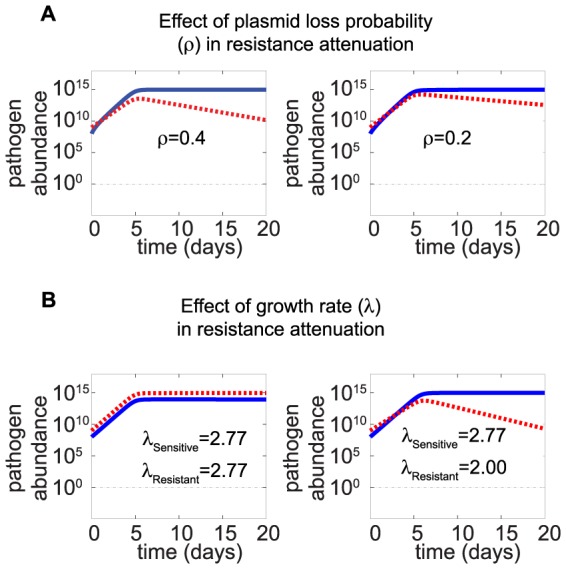
Resistance attenuation occurs in the in the absence of antibiotic treatment when the abundance of sensitive pathogen is saturated.The resistant and sensitive strains have to compete for resources when the bacterial population approaches carrying capacity. This competition reduces the abundance of resistant strains due to the cost of resistance. Under this saturated conditions, both the probability of plasmid loss (A) and the growth rate (B) affect resistance attenuation. (A) The intensity of resistance attenuation increases with the probability of plasmid loss (ρ). (B) The intensity of resistance attenuation increases with the difference in growth rate between both strains. In this analysis, we set up the probability of resistance loss to be equal to zero to highlight only the effects of growth rate. The left panel shows a case in which both sensitive and resistant strains have the same growth rate. In this case, both strains can coexist with high population abundance. In the right panel, we assume that a plasmid cost reduces resistance growth rate from 2.77 to 2 day−1. The abundance of the resistant pathogen decreases over time when the abundance of the sensitive pathogen is saturated. The intensity of resistance attenuation is proportional to the difference in growth rate. Unless otherwise mentioned, all parameters used in this analysis correspond to the default values described in Table S1 in File S1 for no treatment condition. Initial abundances of sensitive and resistant pathogens are 108 and 109 cells respectively.